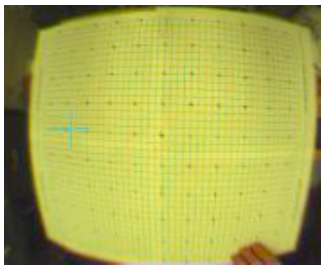
Figure 15: Observed wide‐ angle lens “fisheye” distortion Figure 16. Observed wide-angle lens “fisheye”’ distortion.